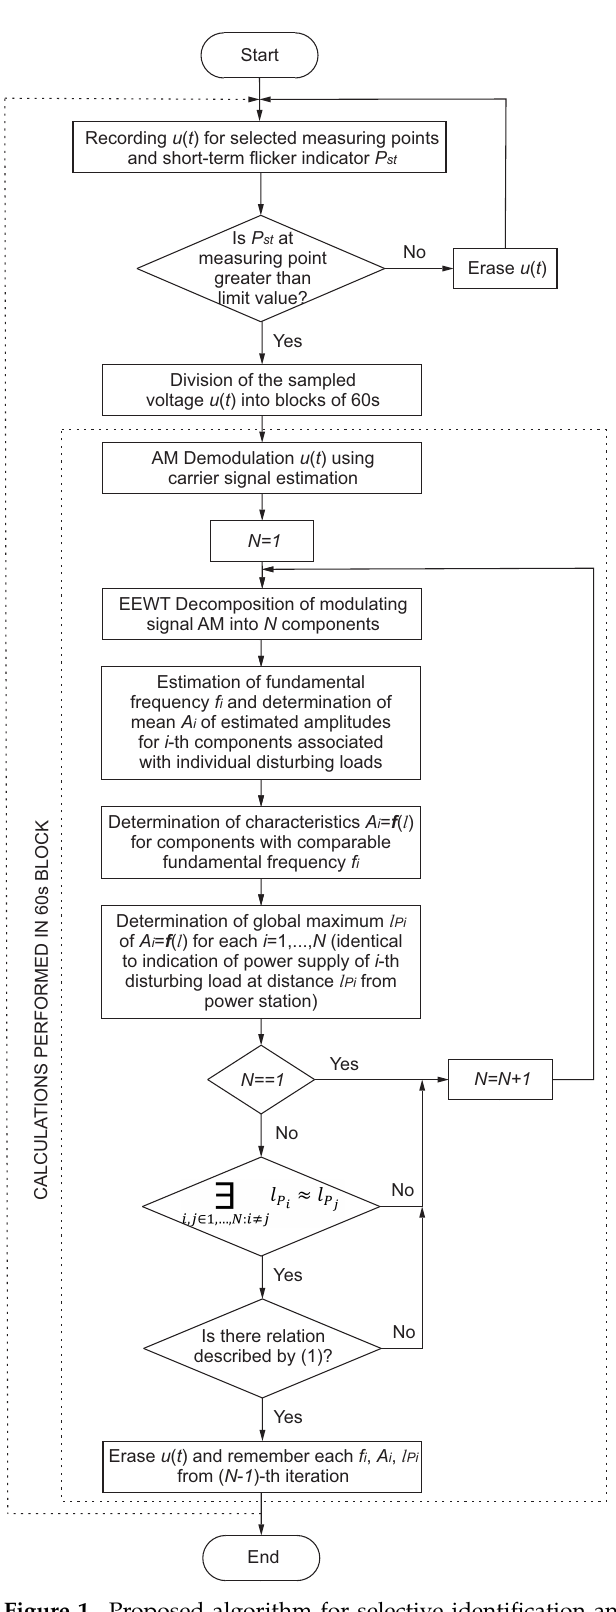
Figure 1. Proposed algorithm for selective identification and localization of individual disturb- ing